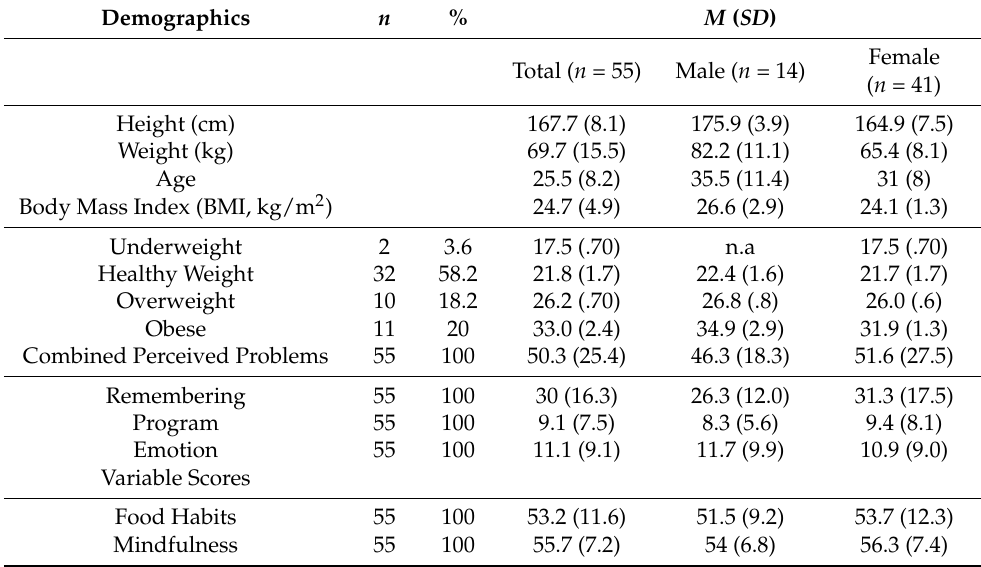
Table 2. Means ( M ) and Standard Deviation ( SD ) Scores for Male ( N = 14), Female ( N = 41), and Total ( N = 55) Participants’ Height, Weight, Age, BMI, and Combined Perceived Problems.